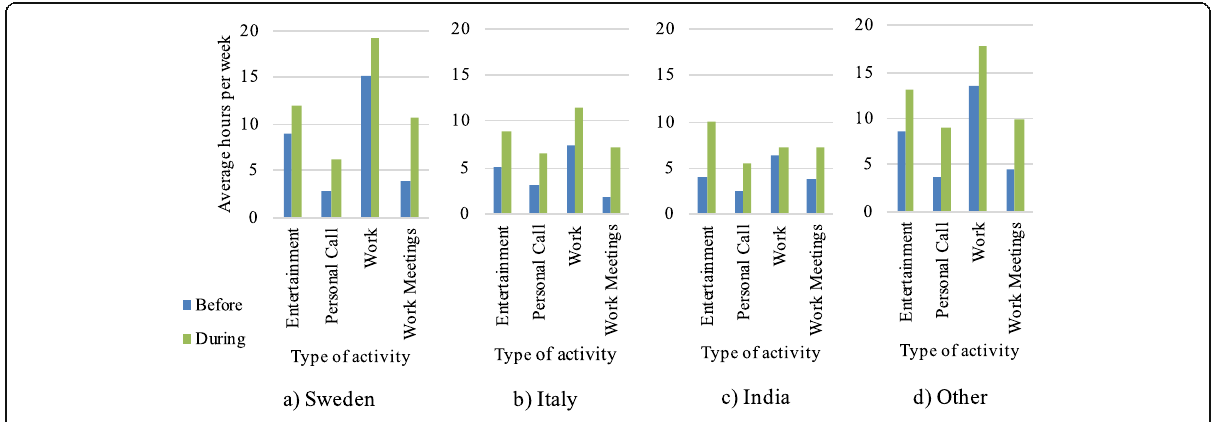
Fig. 4 Average internet usage measured in hours per week, before and during the outbreak period